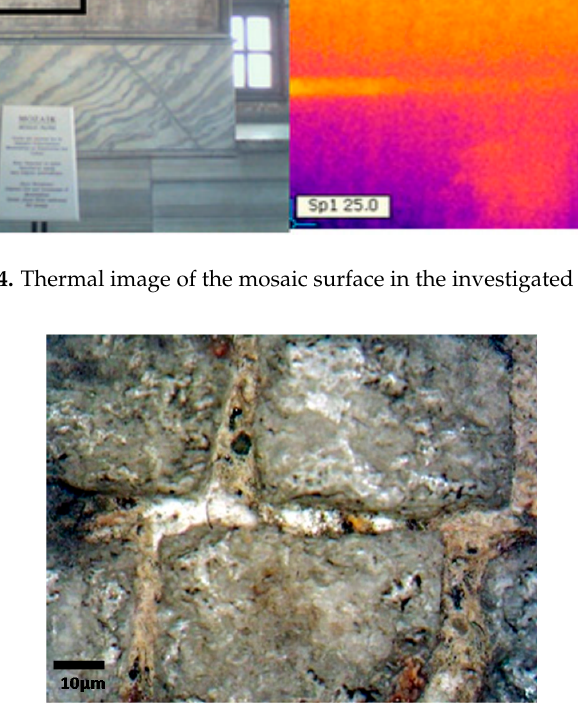
Figure 25. Microscopic image of the mosaic surface in the investigated galleries.